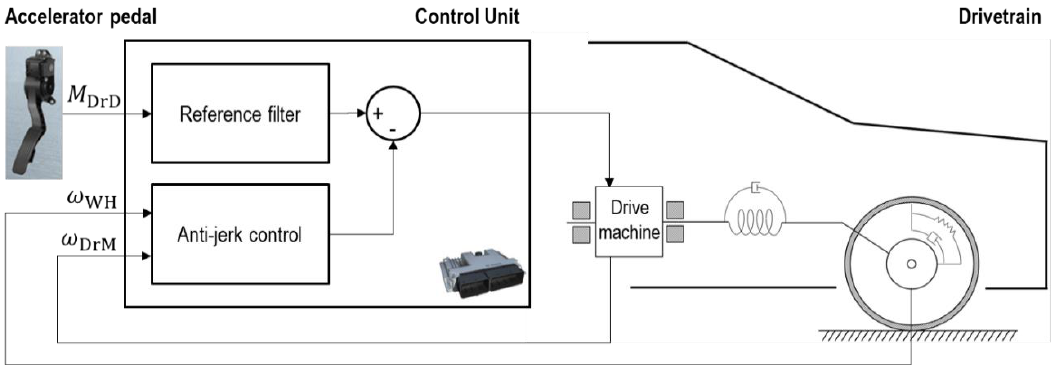
Figure 1. Overview of the drivability function.